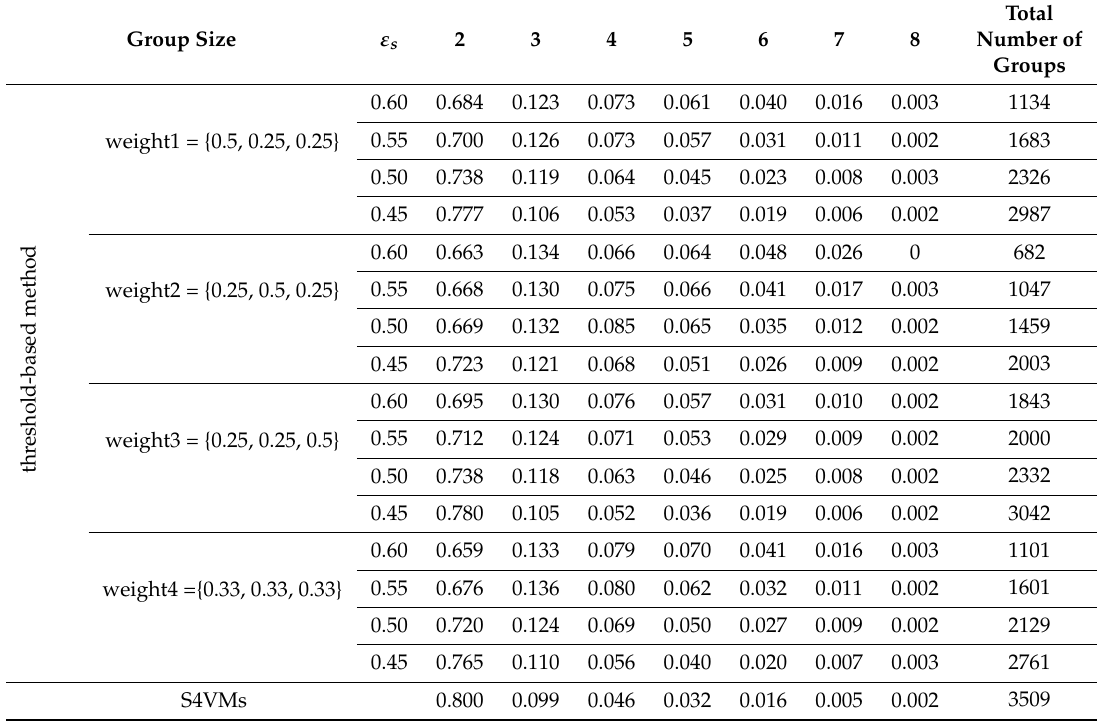
Table 3. Percentage of group